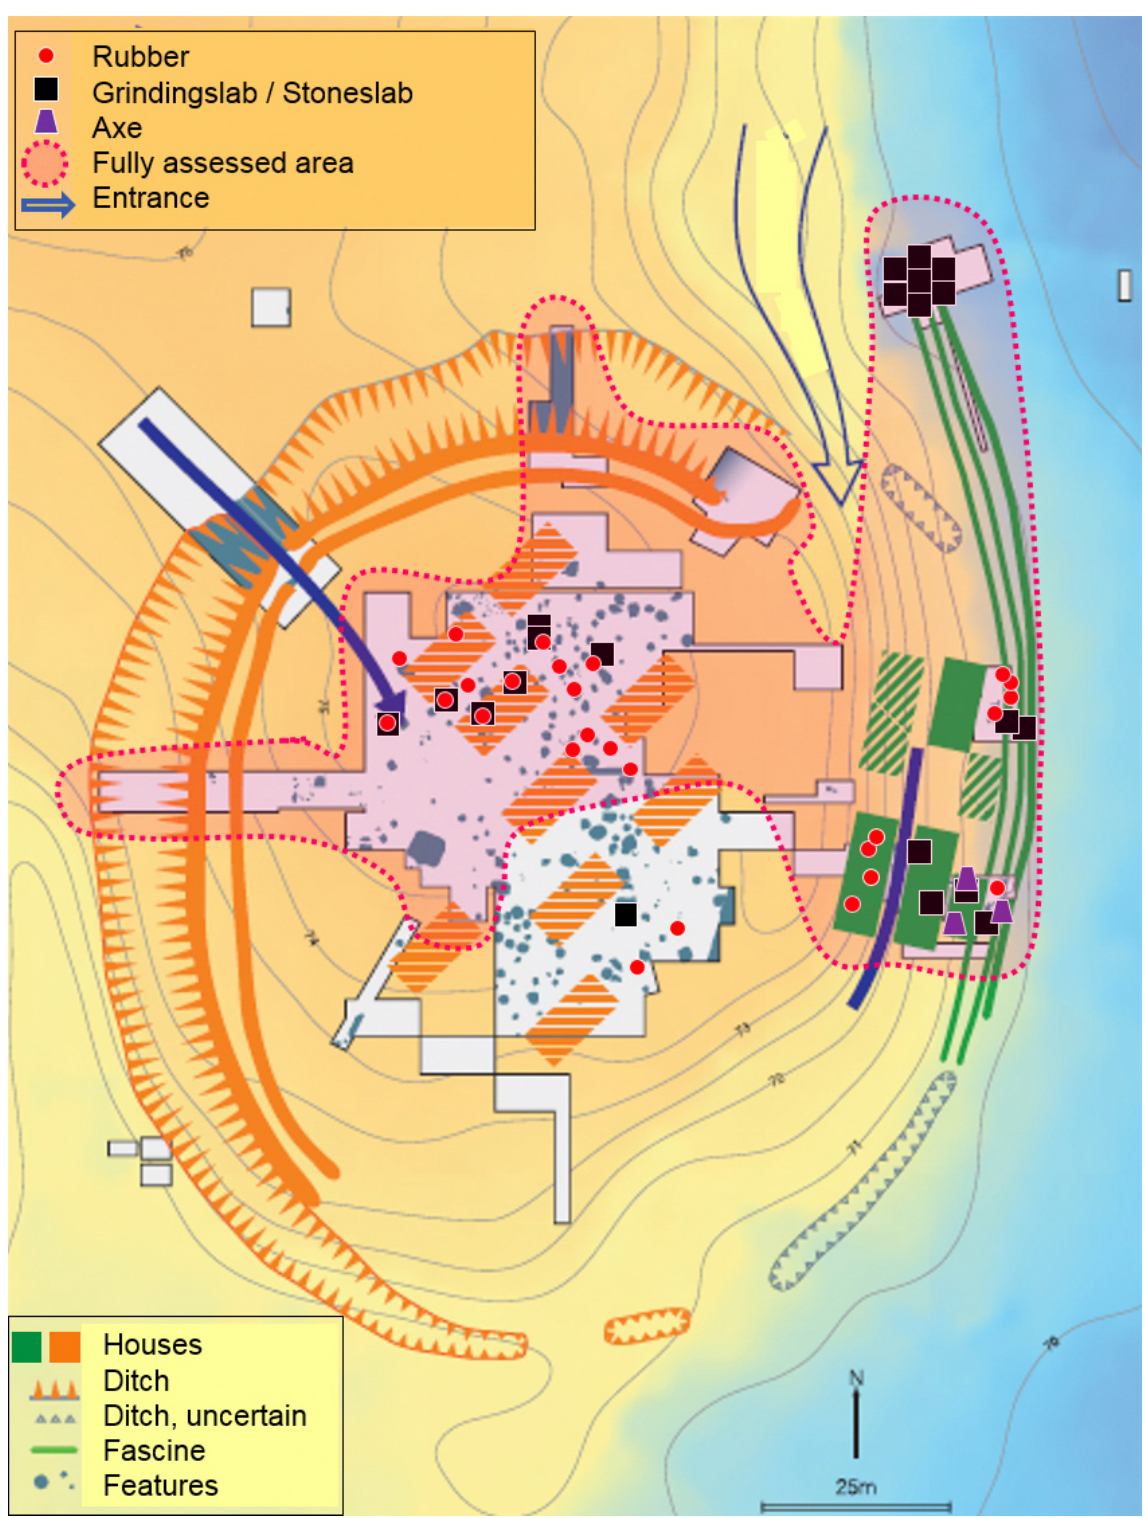
Figure 9. Spatial distribution of food processing macro-lithic tools (grindingslabs, rubbers and stoneslabs) and axes attributed to the Únětice occupation of the site (based on Honig 2004 and Kneisel & Müller: 2011: Abb. 8 and updated). One dot represents one